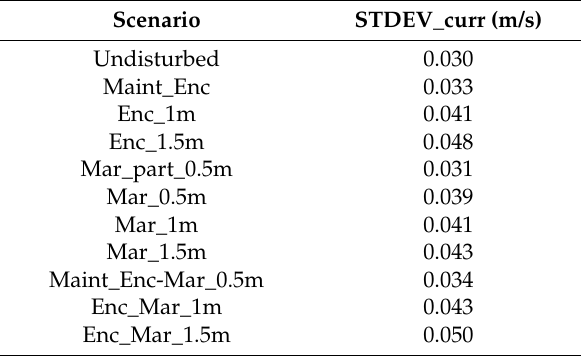
Table 4. Standard deviation of the current velocity modules during the maximum flow through the channel into the